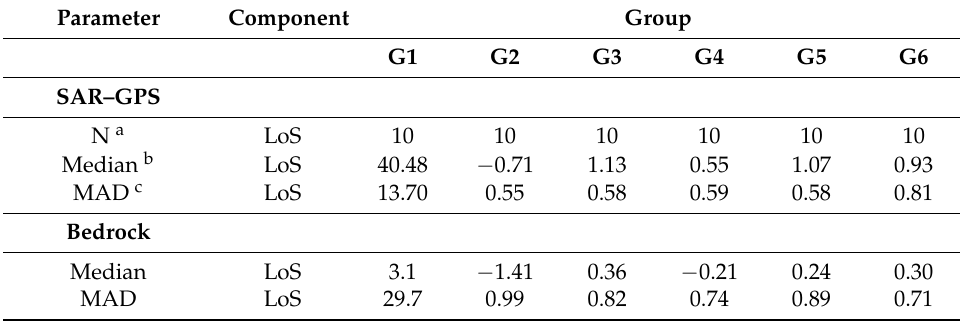
Table 4. Task 1 validation